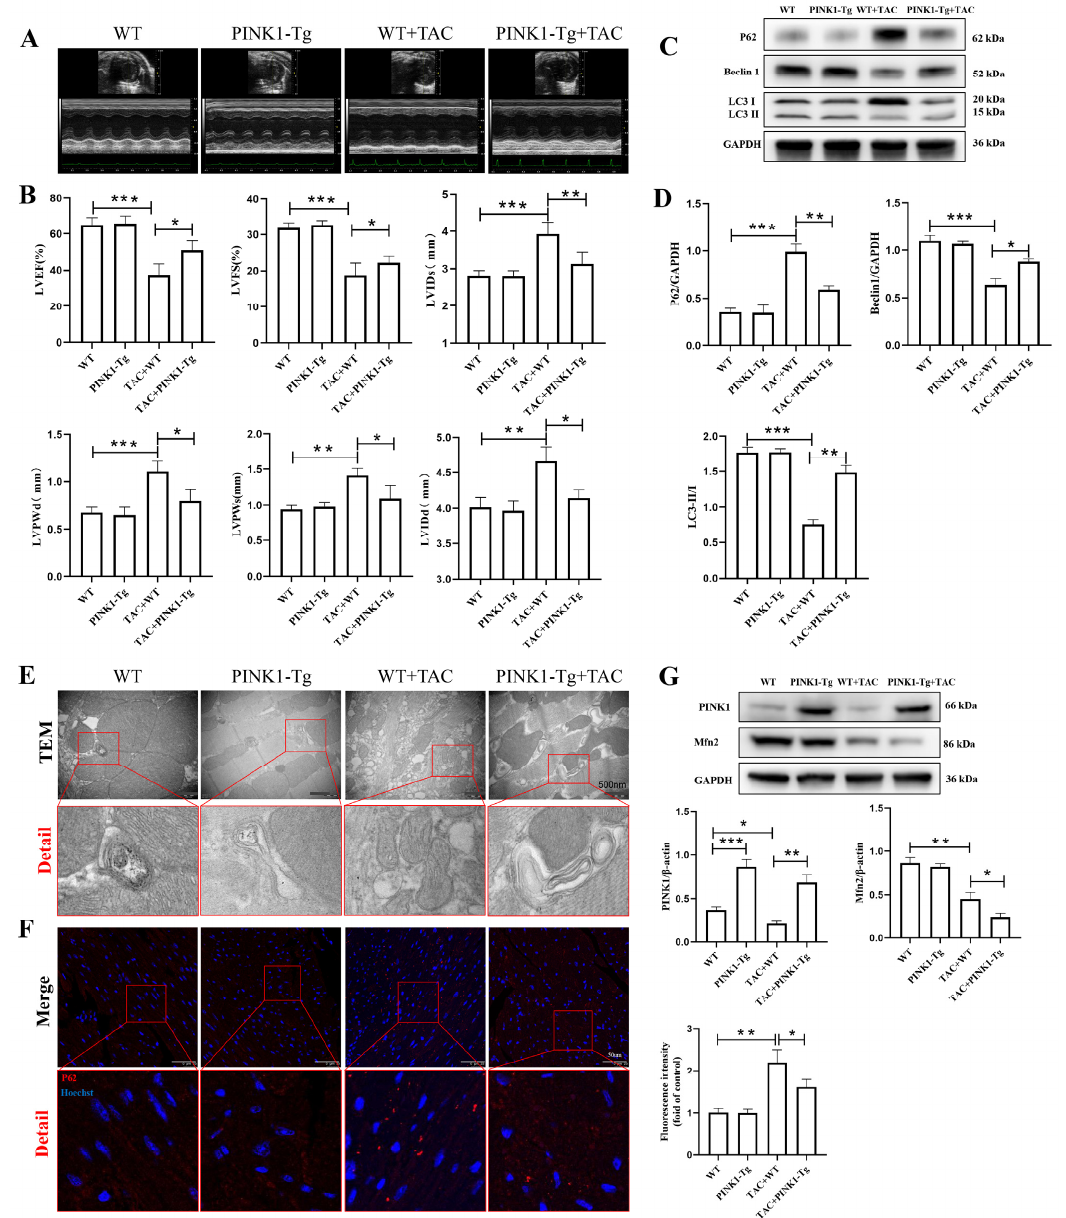
Figure 3. E ff ect of PINK1 overexpression on cardiac function and mitophagy in TAC mice. The echo- Figure 3. Effect of PINK1 overexpression on cardiac function and mitophagy in TAC mice. cardiography (ECG) was administrated at 8 w after surgery ( A , B ): LV ejection fraction (EF), LV frac- tion shortening (FS), left ventricular internal dimension in systole (LVIDs), left ventricular internal dimension in diastole (LVIDd), left ventricular posterior wall in systole (LVPWs), left ventricular posterior wall in diastole (LVPWd). n = 6 for each group. ( C , D ) Immunoblotting showing the expres- sion of P62, Beclin 1 and LC3II in WT and PINK1-Tg mice. Densitometric analyses of the Western